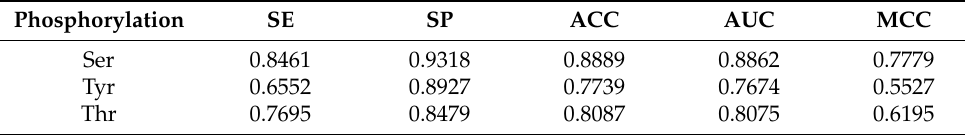
Table 2. The average prediction results of final CNN model by 10-fold